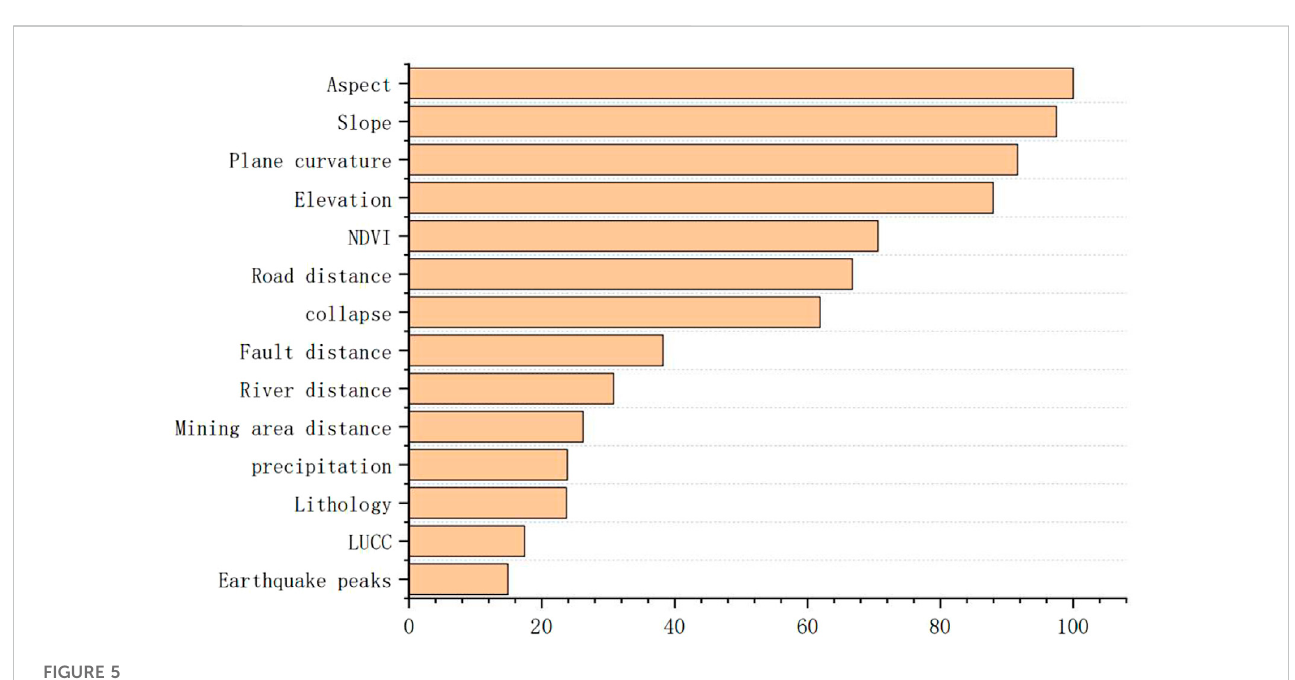
FIGURE 5 Importance of the in fl uencing